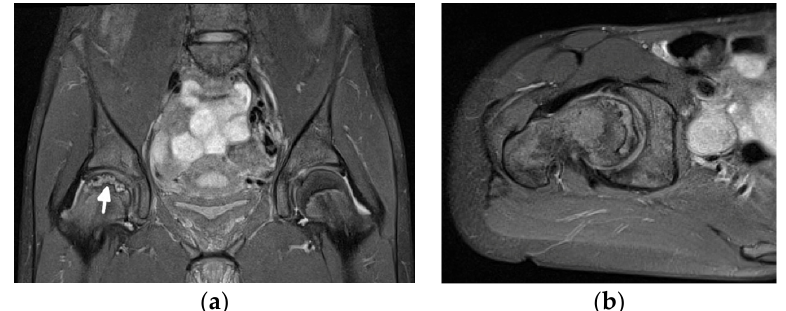
Figure 12. Magnetic resonance (MR) imaging of the femoral head osteonecrosis (ON) in a 14-year-old female with juvenile systemic lupus erythematosus. ( a ) Coronal and ( b ) axial proton density-weighted with fat saturation (right) MR images of the pelvis and right hip show a geographic serpiginous lesion in the right femoral head, with a bone marrow edema irregular contour and demarcation line consistent with ON (arrow).